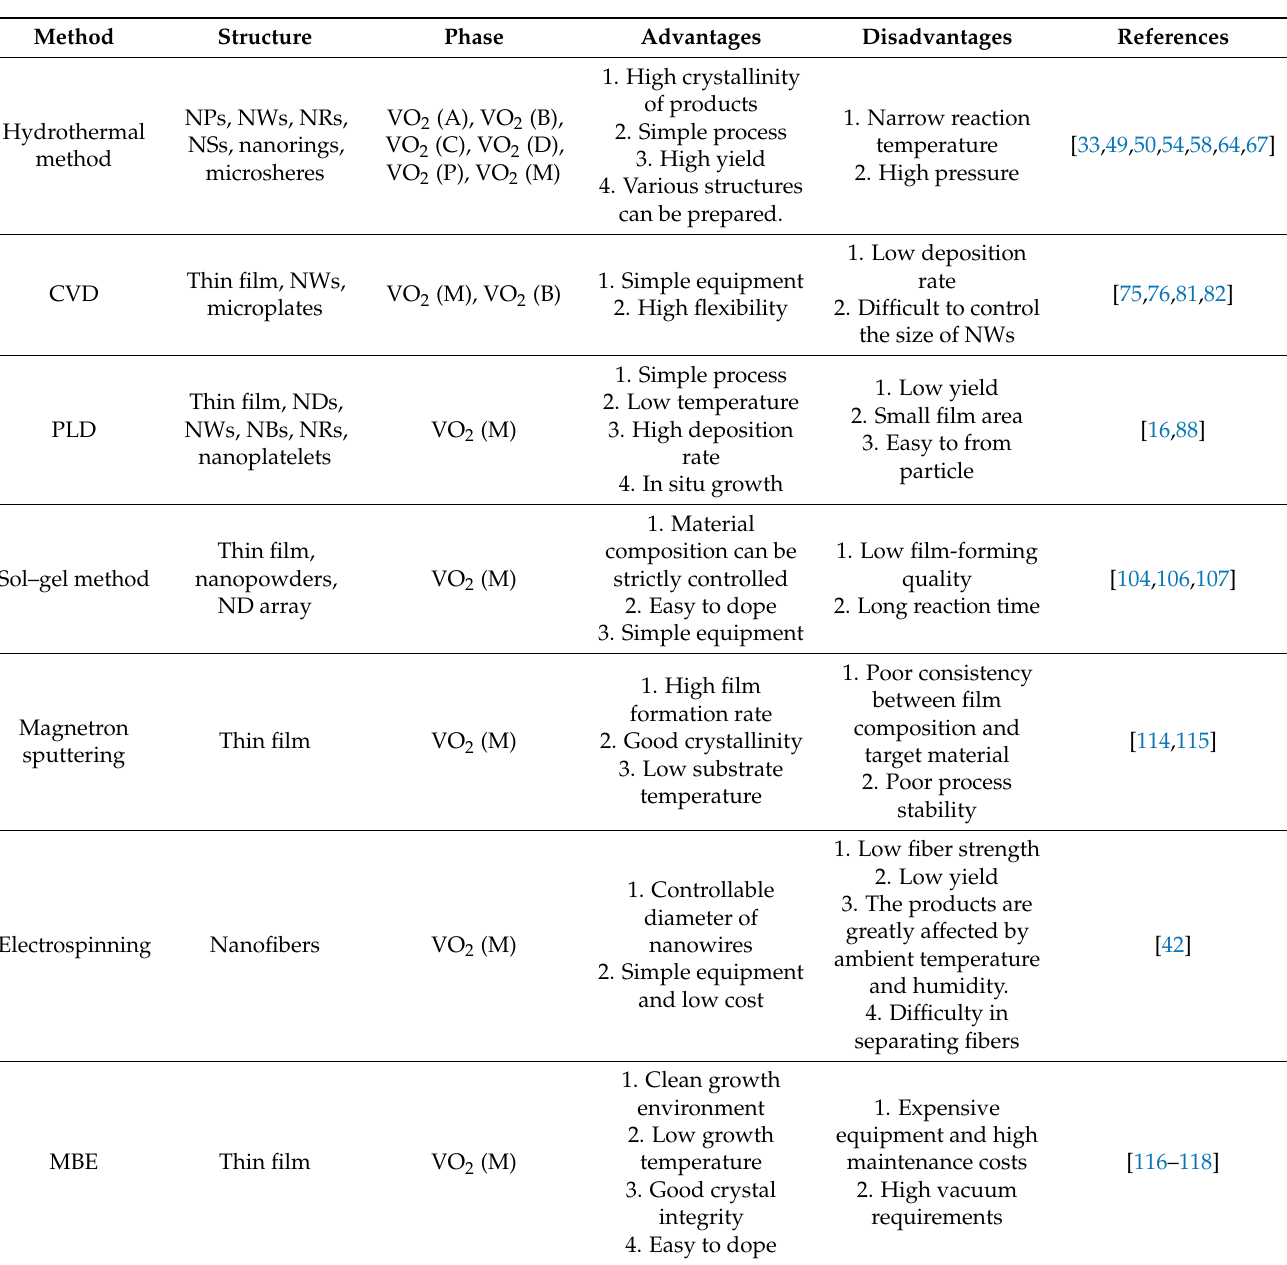
Table 2. The strategies for the growth of VO 2